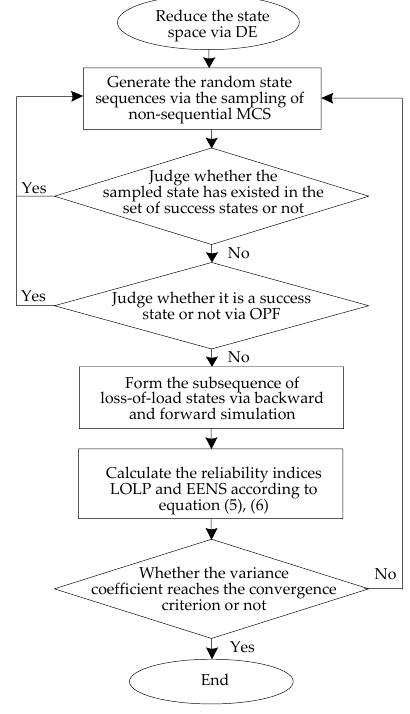
Figure 5. The reliability evaluation process by using PMCS based on the ISSR.